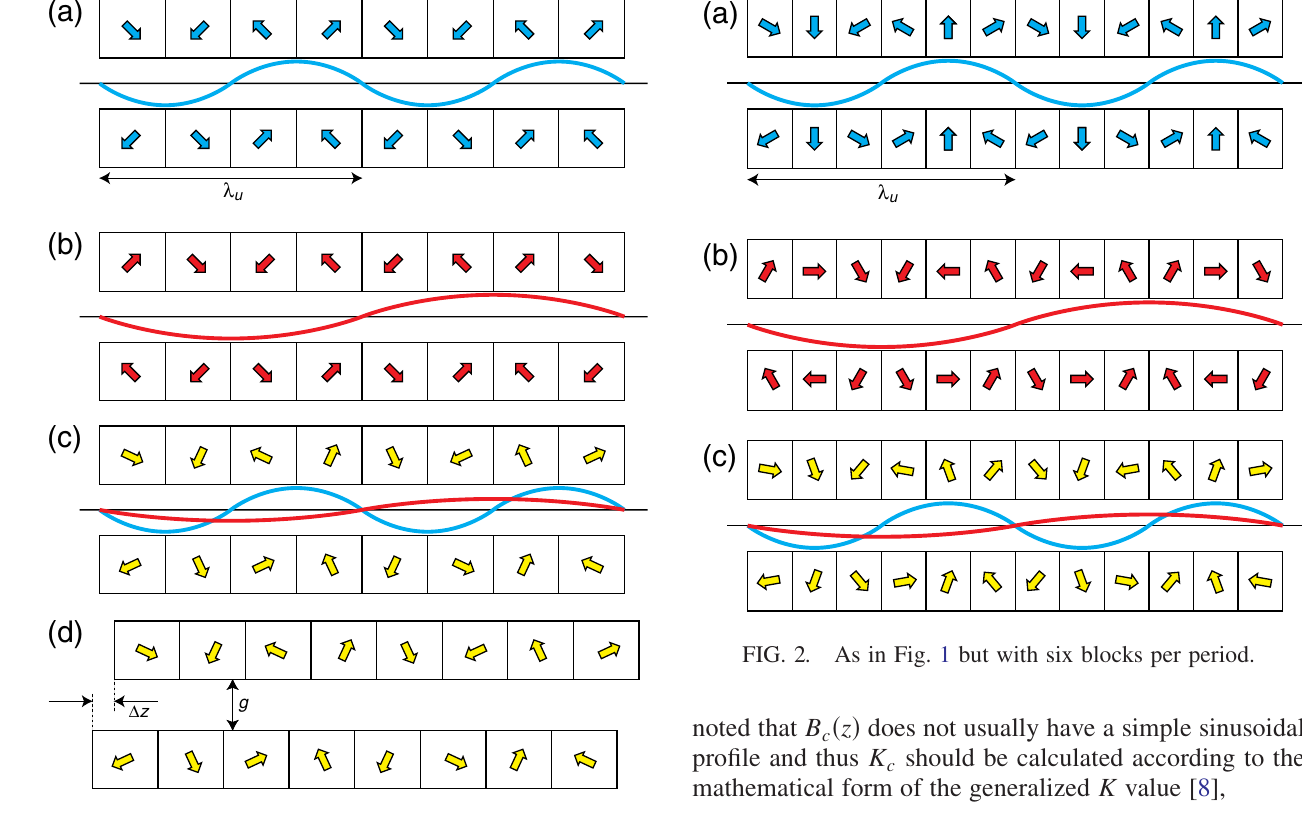
FIG. 1. Halbach-type undulator magnet circuits with four blocks per period (a) for the fundamental period and (b) for the double period. (c) Composite configuration of (a) and (b). (d) Two parameters to tune the photon energy: magnet gap g and magnet shift (cid:1) z